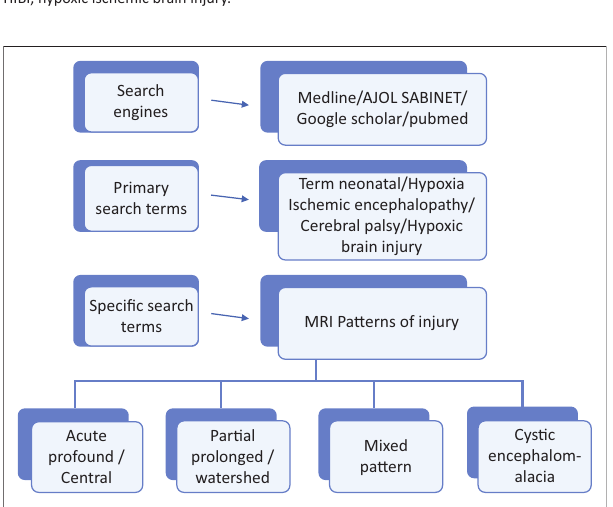
FIGURE 2: Contextual framework of the narrative review process for term neonatal hypoxic ischemic encephalopathy and the resultant neuroimaging patterns.